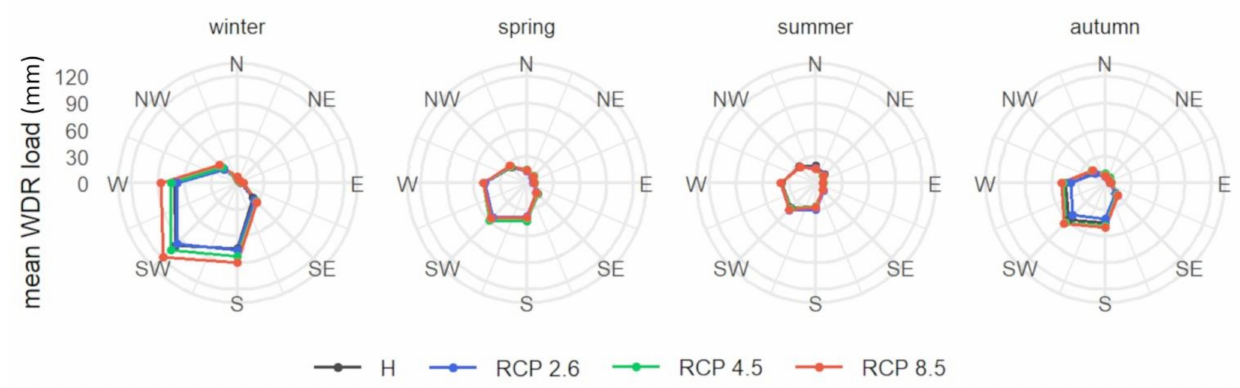
Figure 2. Mean wind-driven rain (WDR) load per season for historical (H) and future periods for the rain exposure coefficient of